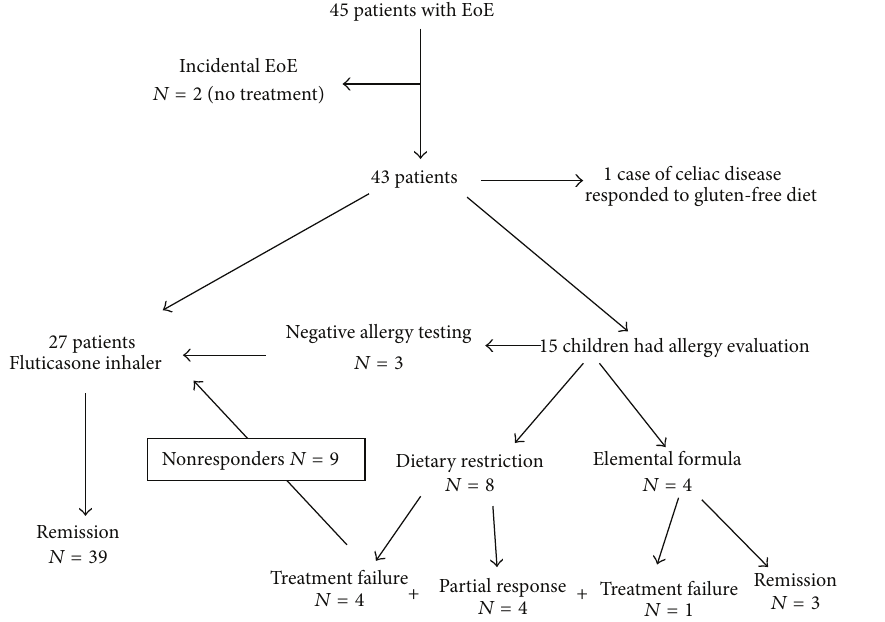
Figure 2: Diagram of 45 patients with eosinophilic esophagitis: treatment and outcome.